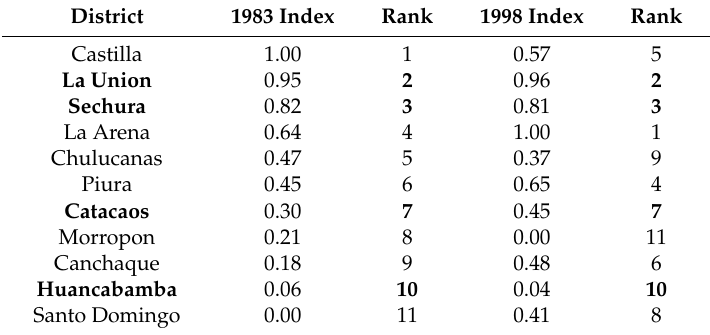
Figure 10. Maps comparing ecosyndemic indices according to rank for 1983 and 1998 across 11 districts in the Piura subregion. Table 6. Comparison of 1983 and 1998 ecosyndemic indices by rank across 11